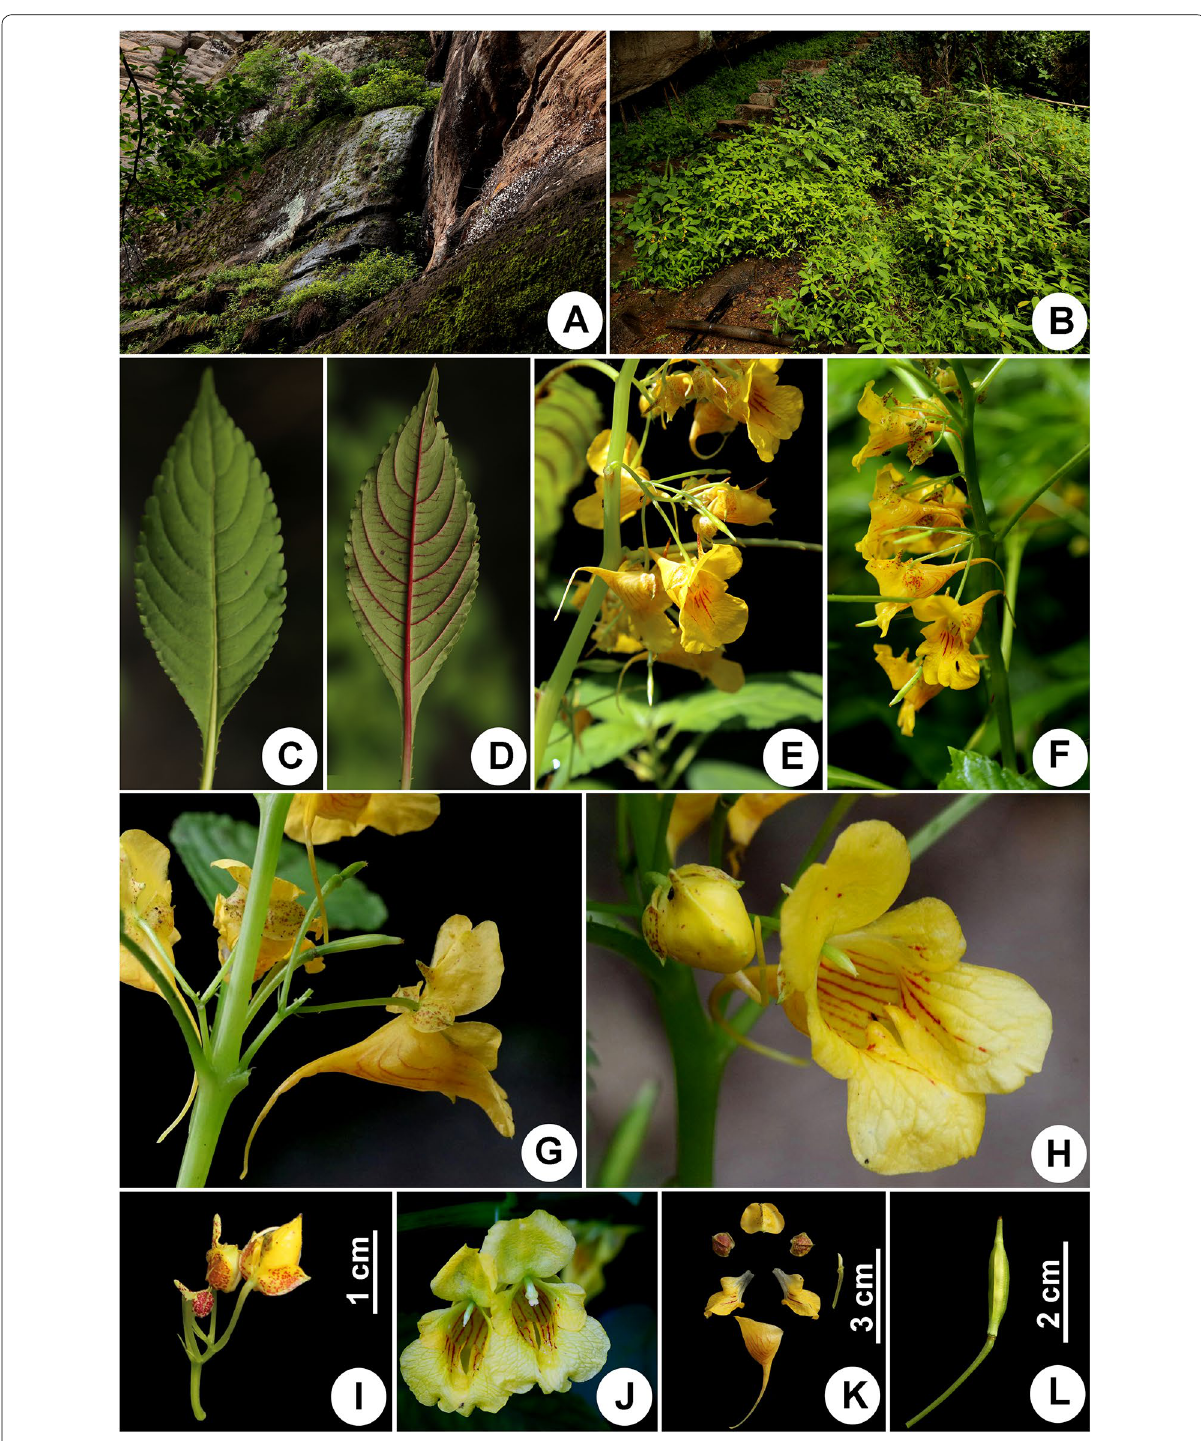
Fig. 5 Impatiens wuyiensis J.S.Wang, Y.F.Lu & X.F.Jin. a, b habitat; c adaxial surface of leaf; d abaxial surface of leaf; e , f inflorescence; g lateral view of flower; h frontal view of flower; i pedicel and bract; j upper petal and lateral united petals; k flower structure; l